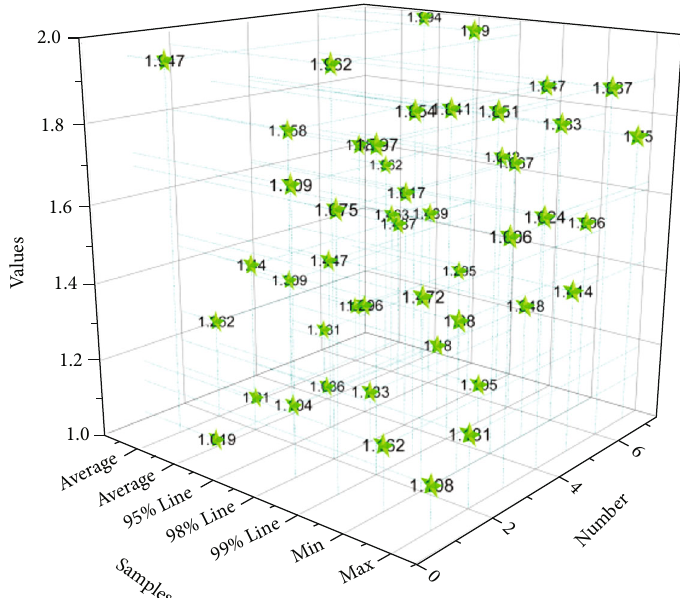
Figure 5: Detection model test